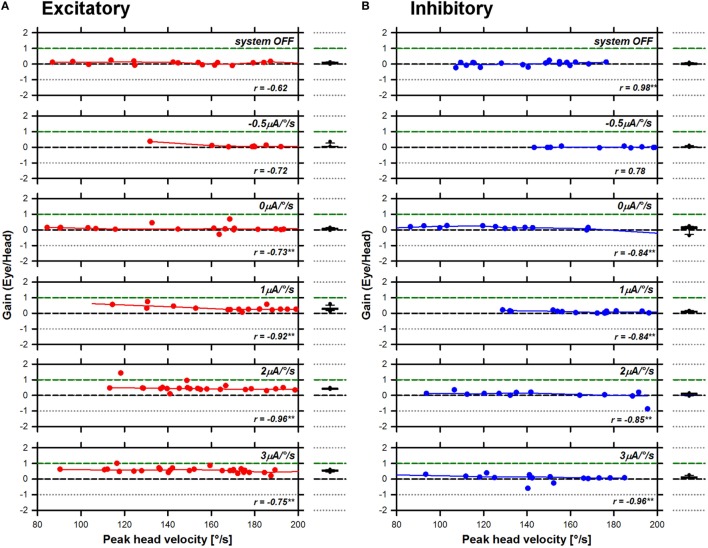
Angular vestibulo-ocular reflex (aVOR) gains recorded for S2 horizontal in all experimental conditions. Panel (A) presents data gathered during excitatory head impulses (red plots), and panel (B) presents data gathered during inhibitory head impulses (blue plots). The line and scatter plots in the main panel present individual aVOR gains (scatter) as well as their corresponding smoothed (LOWESS, see Materials and Methods) values (lines) as a function of peak head angular velocity. The insets in the graph present the result of the statistical analysis for each condition (Pearson’s product-moment correlation coefficient; **p < 0.001—two-tailed). The box plots to the right present the median values, as well as the 25th–75th percentiles of the smoothed data pooled across head velocities. The error bars represent the 10th and 90th percentiles and the symbols present all outliers outside this range.